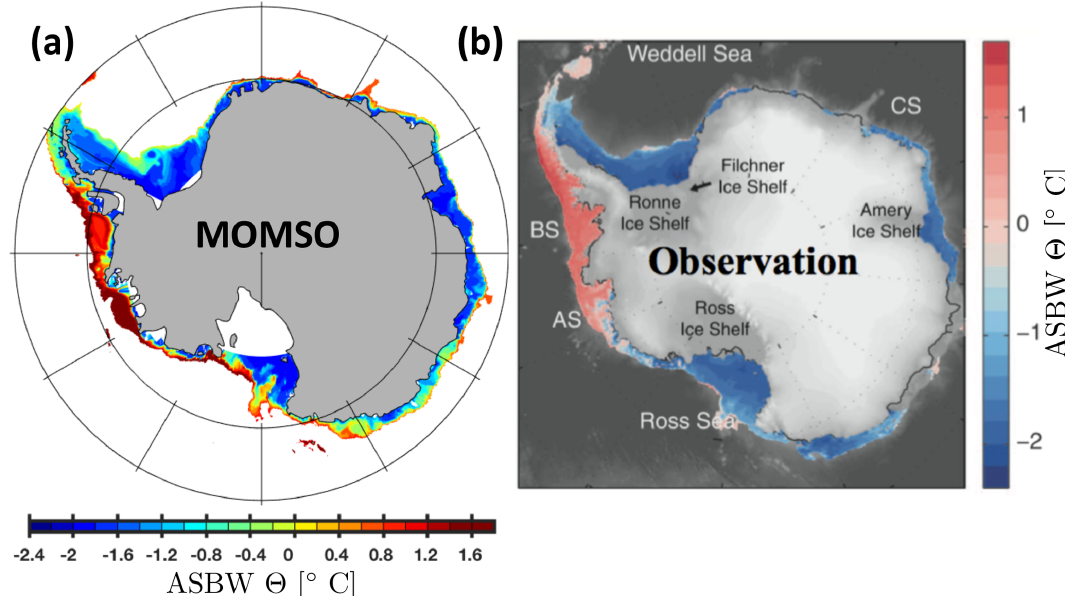
Figure 33. Temperature of ASBW at the seabed for depths shallower than 1500m. Panels (a) and (b) refer to the simulated 1993–1998 climatology and observations reproduced from Schmidtko et al. (2014), respectively.